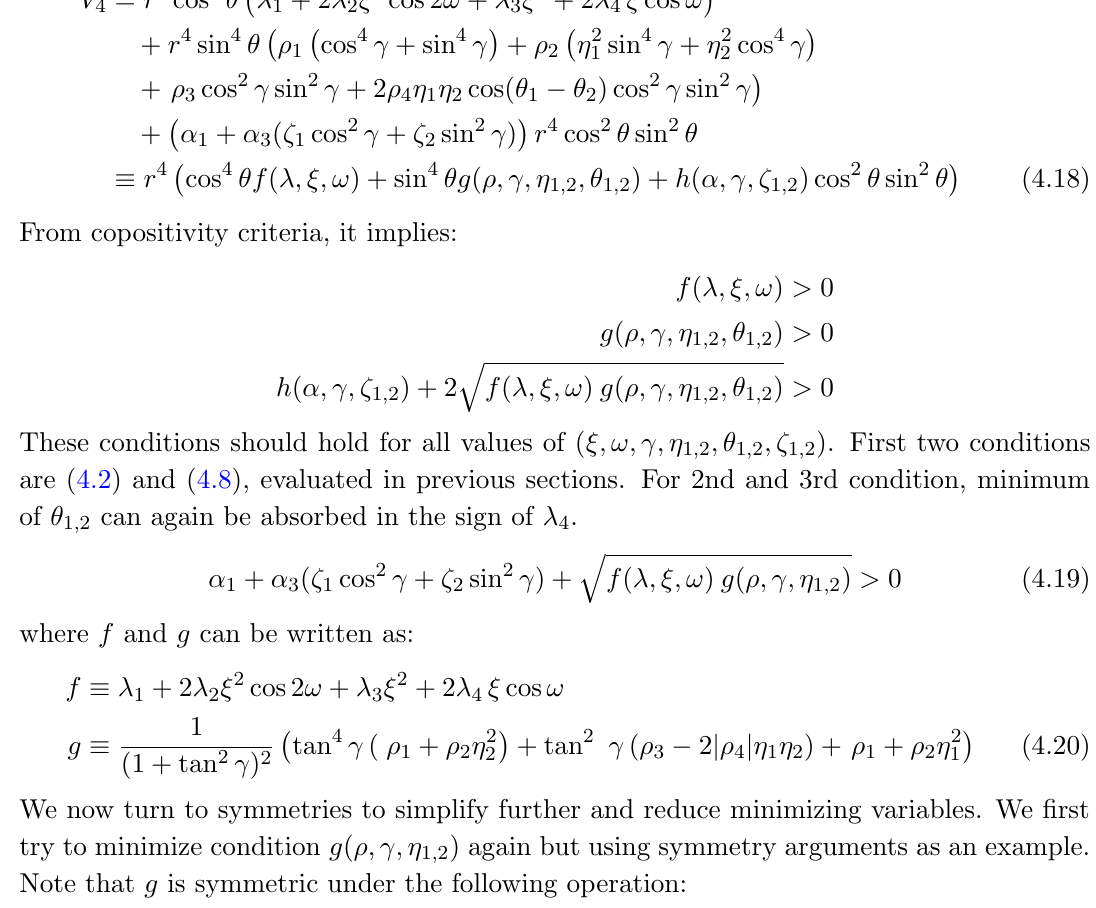
Figure 1 . Dependence of gauge orbit variable (cid:16) i on (cid:24) and (cid:17) i . (Left) Scatter plot of (cid:16) with respect to (cid:24) and (cid:17) . (Right) Plot of (cid:16) as a function of (cid:24) and (cid:17) given in eq. (4.17). Substituting the above de(cid:12)ned gauge orbit variables in eq.